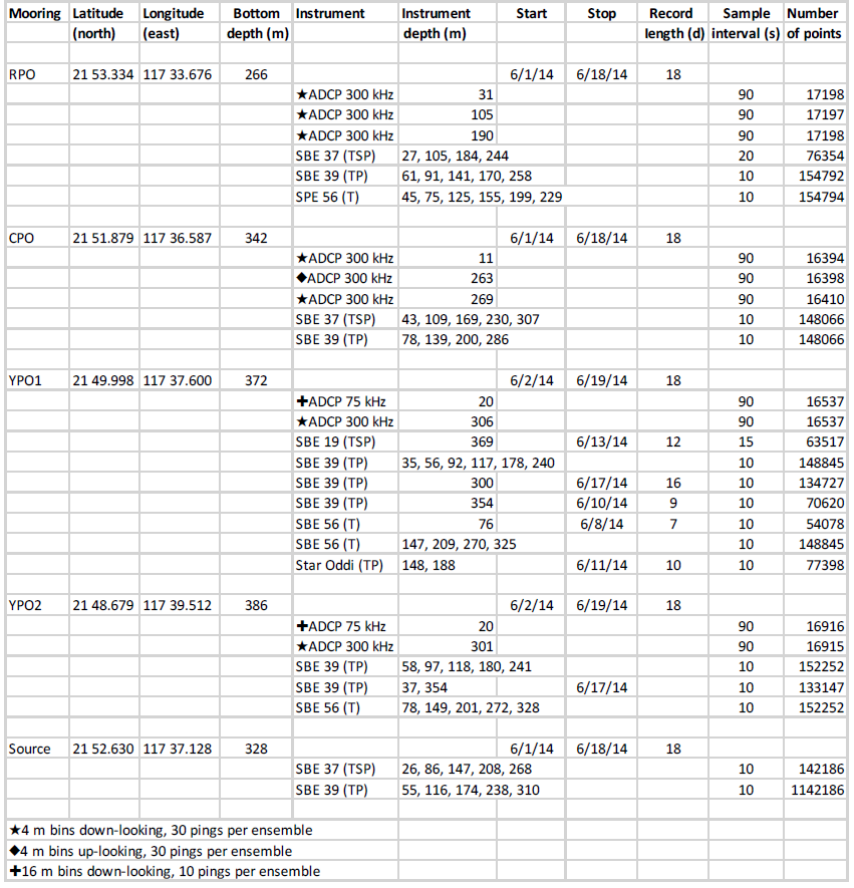
Table A1. Mooring and instrument locations and